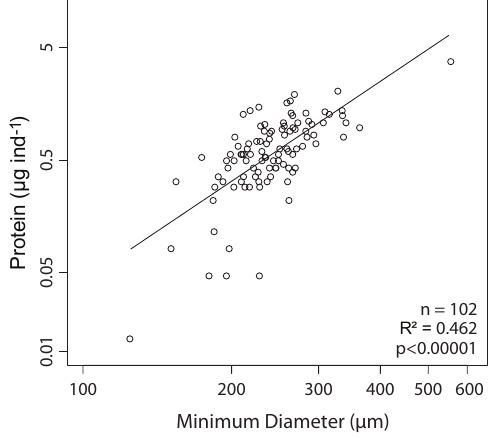
Fig. 3. Correlation between protein content and minimum test di- ameter of A. tepida . Residual standard error=0.626. Without the single large specimen > 500m, the correlation is still significant ( R 2 = 0 . 439, p < 0 . 00001, residual standard error=0.626, expo- nential fit).